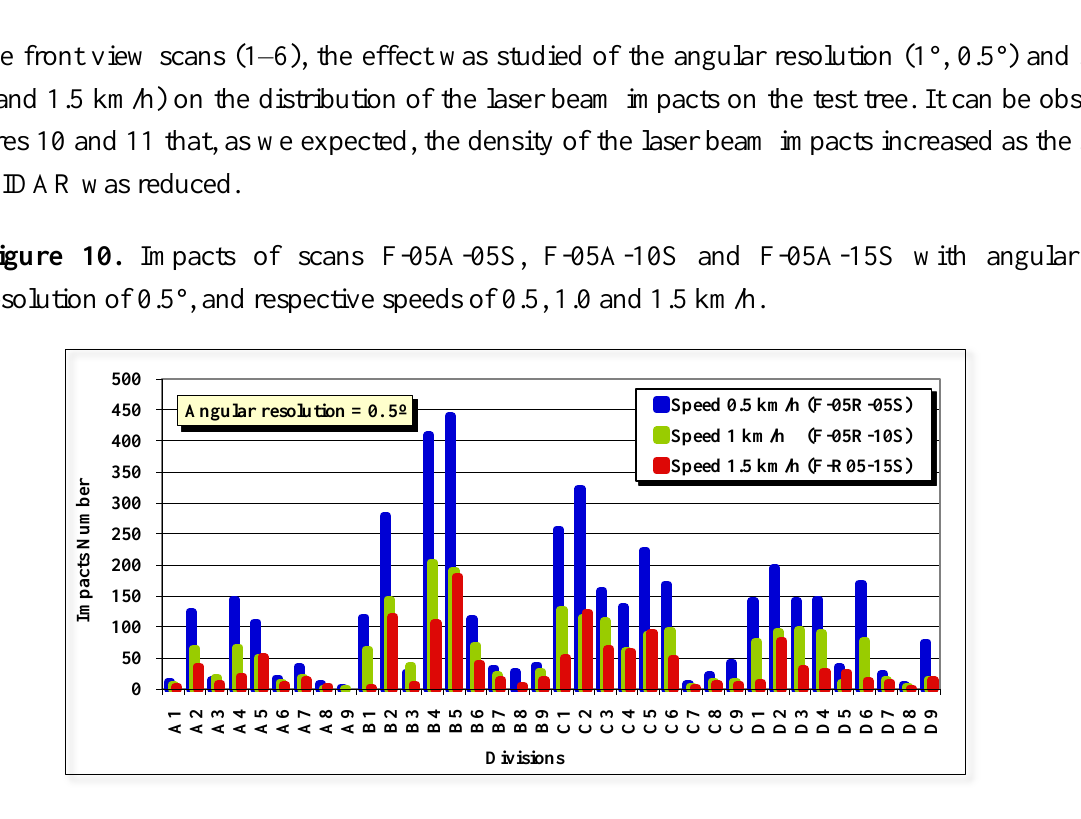
Figure 11. Impacts of scans F-10A-05S, F-10A-10S and F-10A-15S with angular resolution of 1°, and respective speeds of 0.5, 1.0 and 1.5